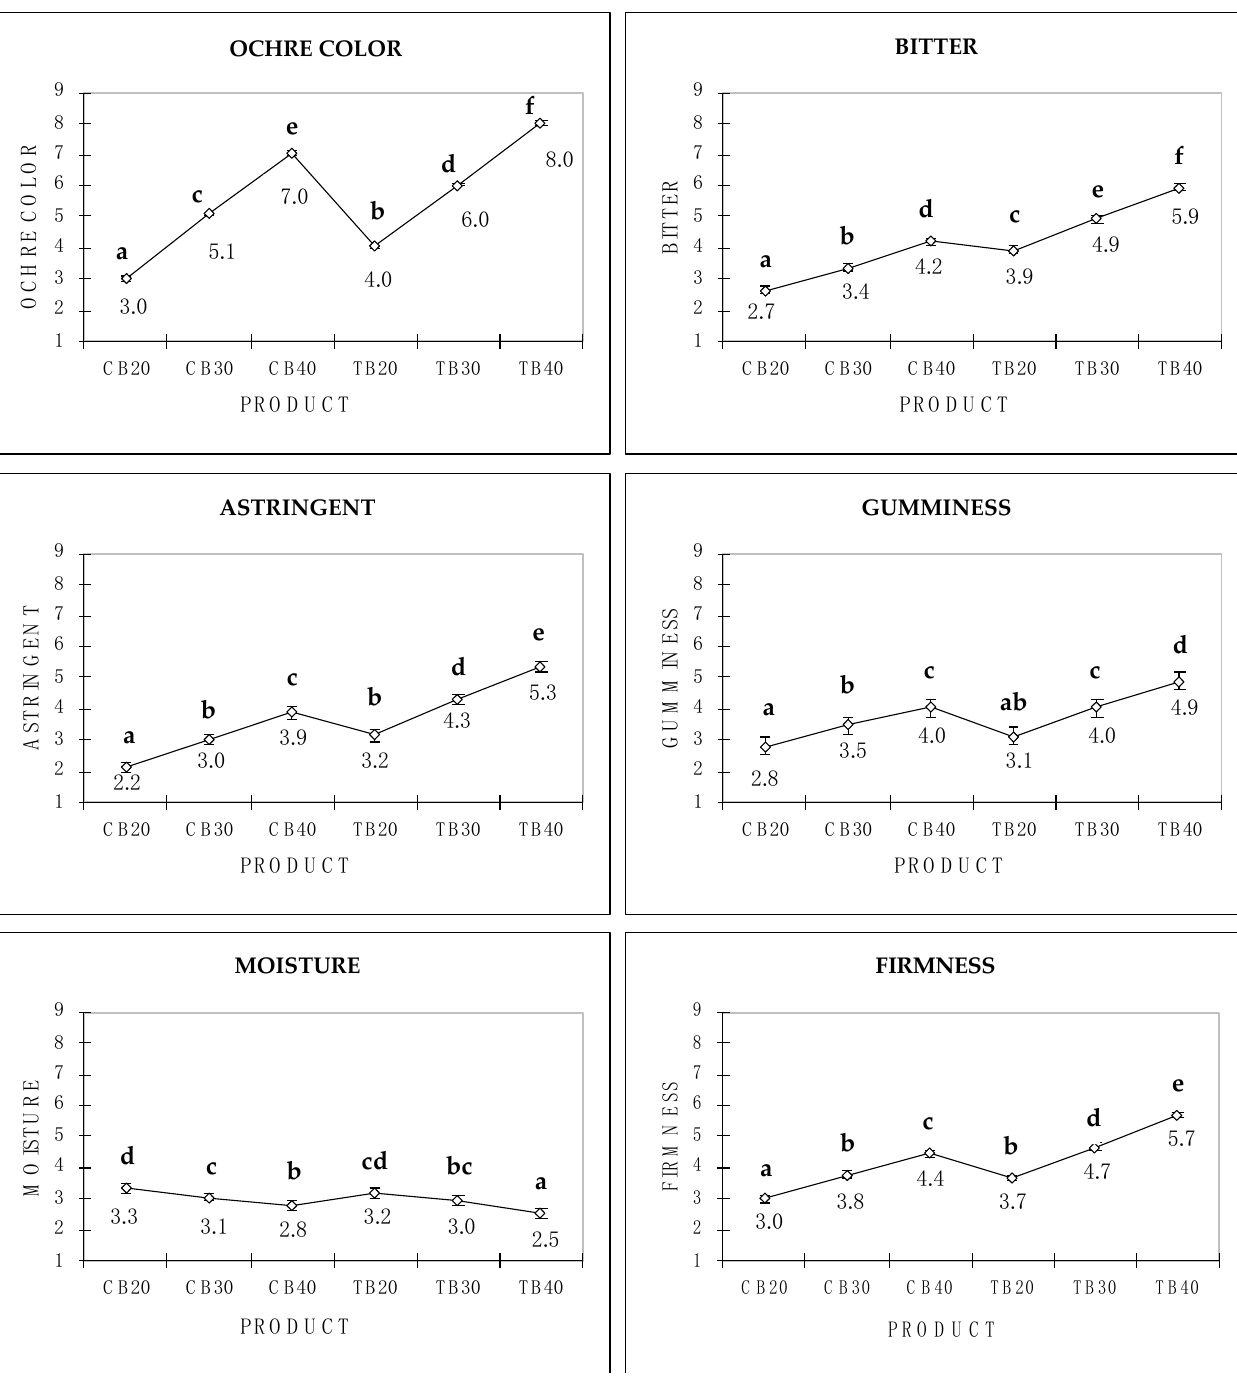
Figure 3. Sensory attribute mean values by product (CB = Common buckwheat; TB = Tartary buckwheat). Error bars represent standard error of means (SEM). Different letters indicate significant differences according to LSD post hoc test ( p ≤ 0.05).